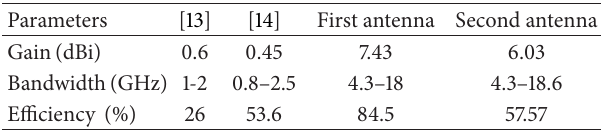
Table 2: Dimension of some of the UWB antennas in comparison to the proposed UWB